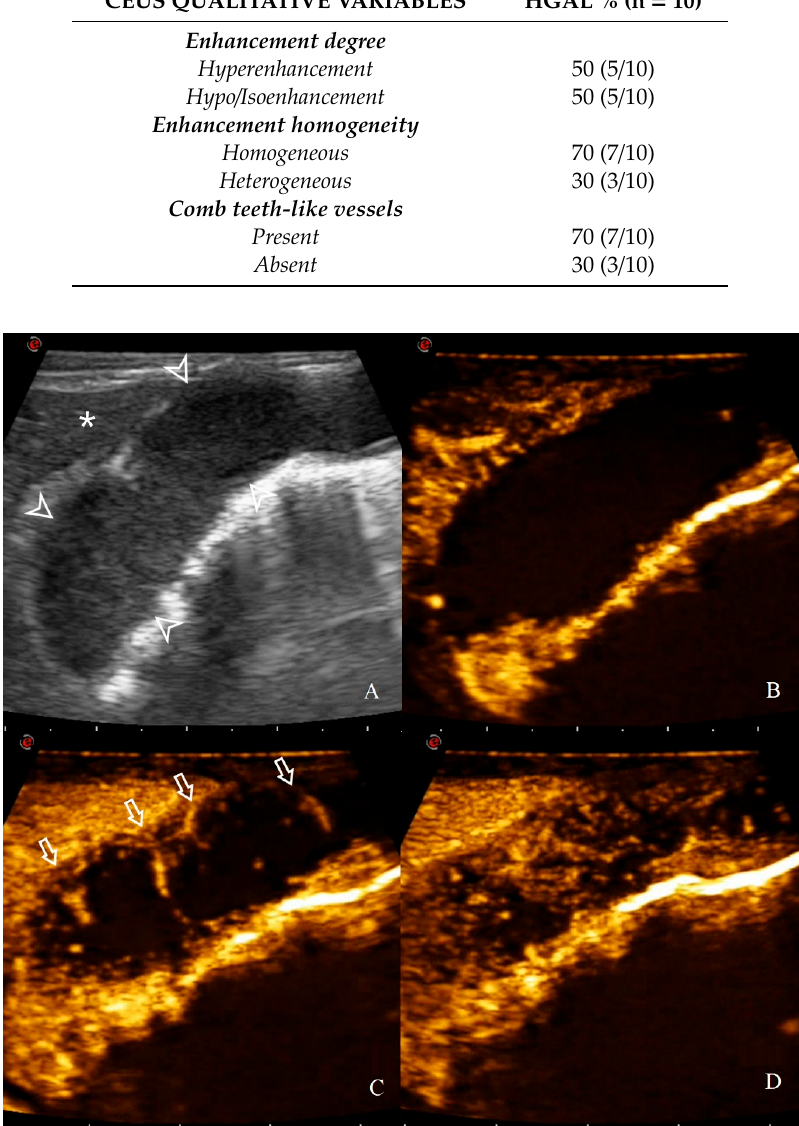
Figure 11. CEUS enhancement pattern in a 7-year-old cat with gastric HGAL: ( A ) before contrast medium (CM) injection (0 s), the gastric mass (14.8 mm between arrowheads) and the adjacent liver parenchyma (asterisk) are visualized; ( B ) after CM injection (8 s), uptake occurs first in the liver and the gastric mass is classified as hypo-enhancing; ( C ) when CM arrives at the lesion site (14 s), comb teeth-like vessels are present (arrows); ( D ) at peak enhancement time (18 s), arterial branching is not visible anymore and enhancement homogeneity is classified as heterogeneous.